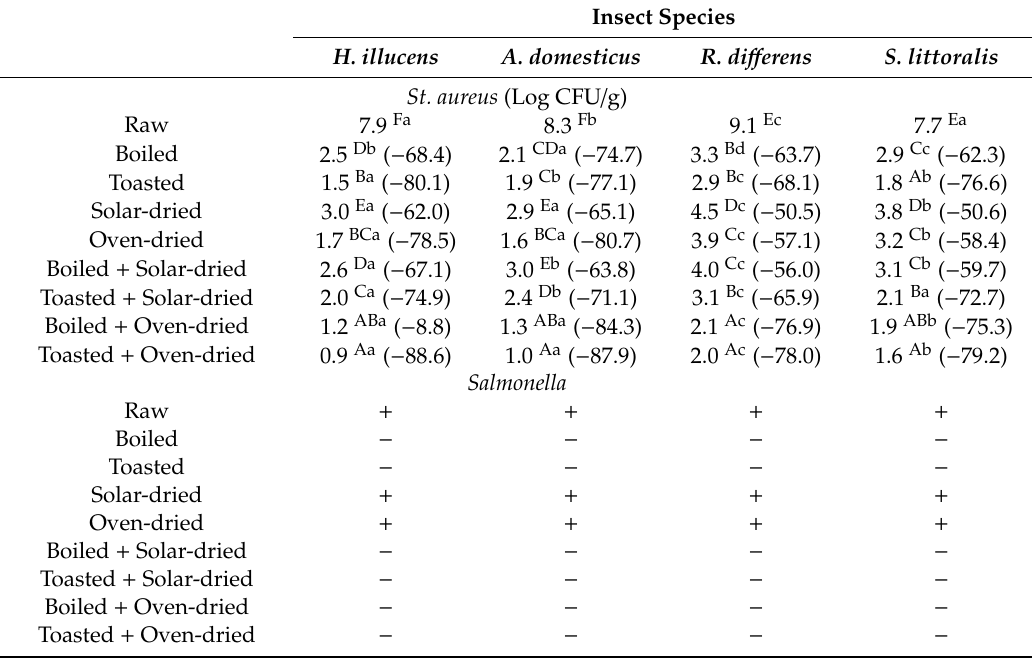
Table 5. Counts of St. aureus, and presence ( + ) or absence ( − ) of Salmonella on the raw and processed